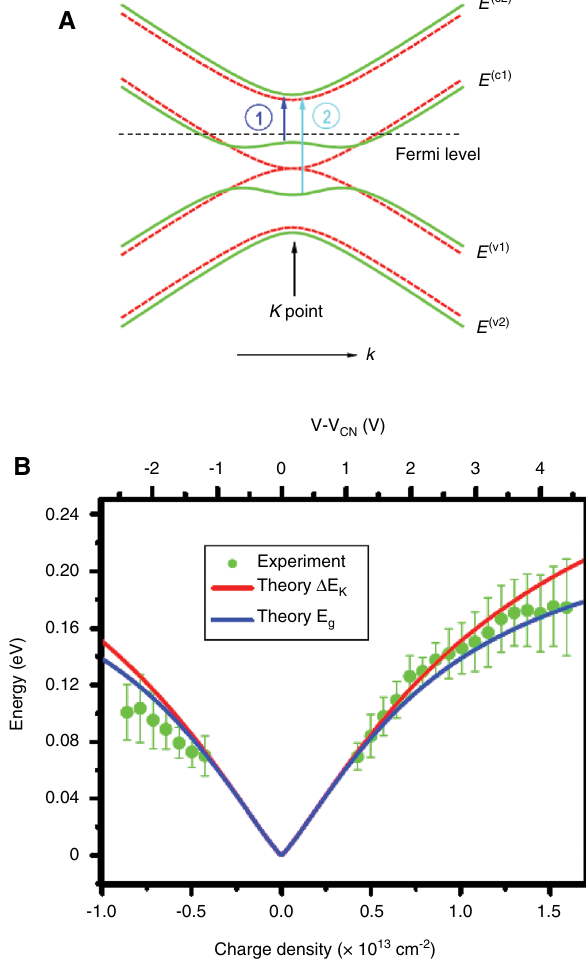
Figure 3 Band-gap opening in top gated bilayer graphene. (A) Illustration of the band structure and the dominant two optical transitions which contribute to the absorption spectra. In this case, the optical transition direct across the opened band gap is not available. (B) Extracted band-gap energy as a function of the charge carrier density and top gate voltage. Solid curves are theoretical cal- culations. Red curve Δ E is the calculated energy difference between K transitions 1 and 2 shown in (A). Blue curve E is the computed g band gap (A–B reprinted with permission from [27], Copyright 2009 American Physical